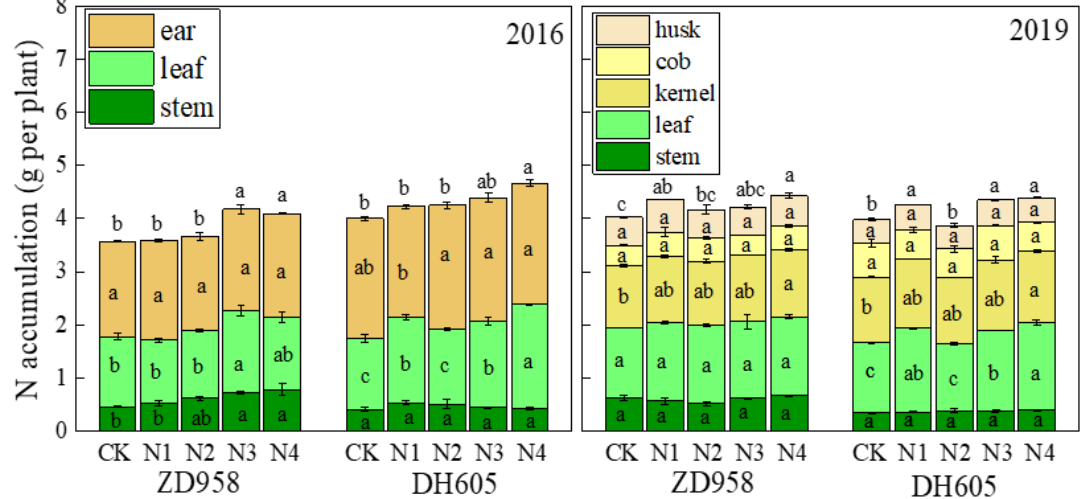
Figure 6. Effects of N treatments on N accumulation in the R6 stage of maize in 2016 and 2019. Total N contents of the leaf and stem were examined, and the ear was further divided into the husk, cob, and kernel in 2019. One-way analysis of variance with Duncan’s new multiple range test was conducted to assess the statistical patterns. Different letters indicate a significant difference ( p < 0.05).